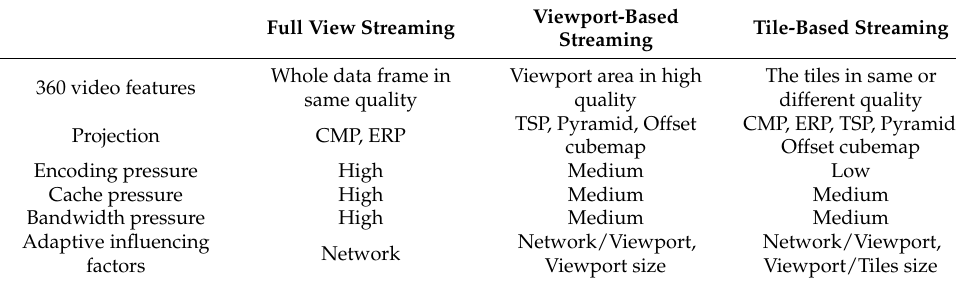
Table 2. The influencing factors of